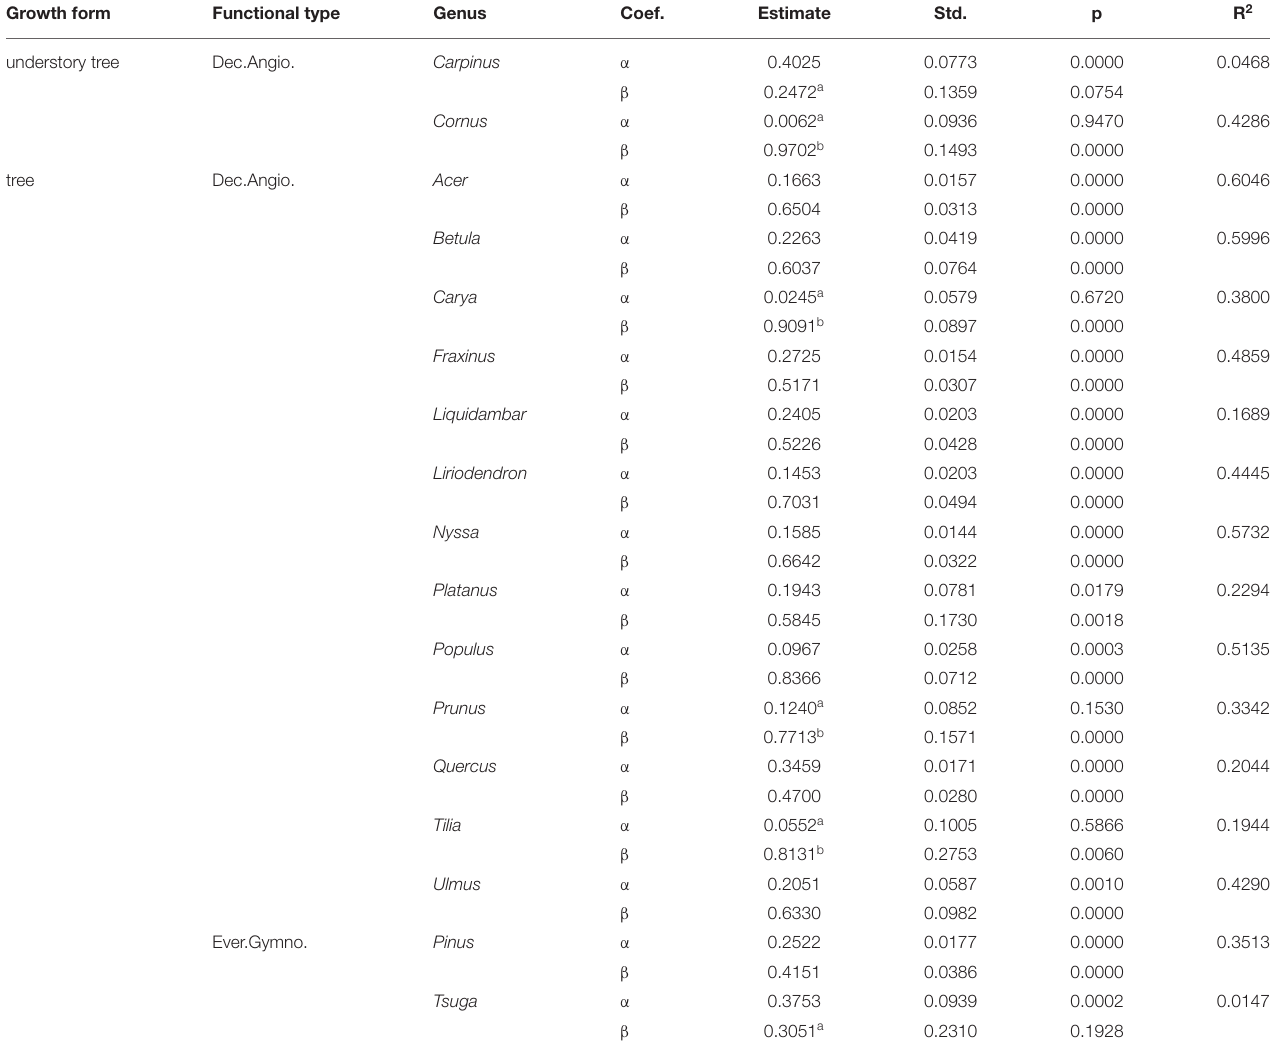
TABLE 4 | Linear models relating tree average branch basic density to average stem basic density (g cm − 3 ) for trees of different genera, listed by growth form and functional type. Growth